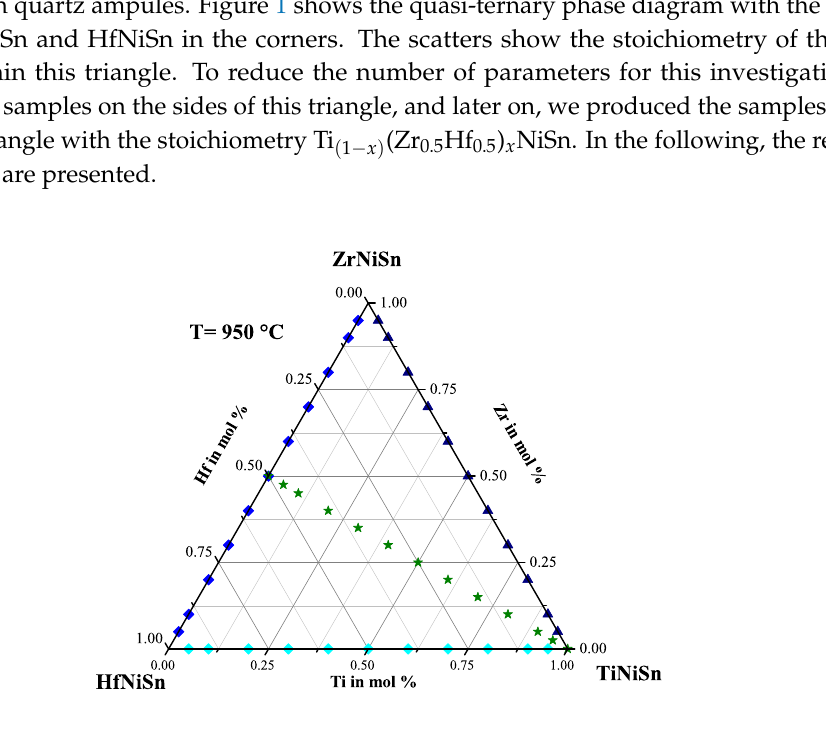
Figure 1. The stoichiometry of the produced samples is shown in the quasi-ternary phase